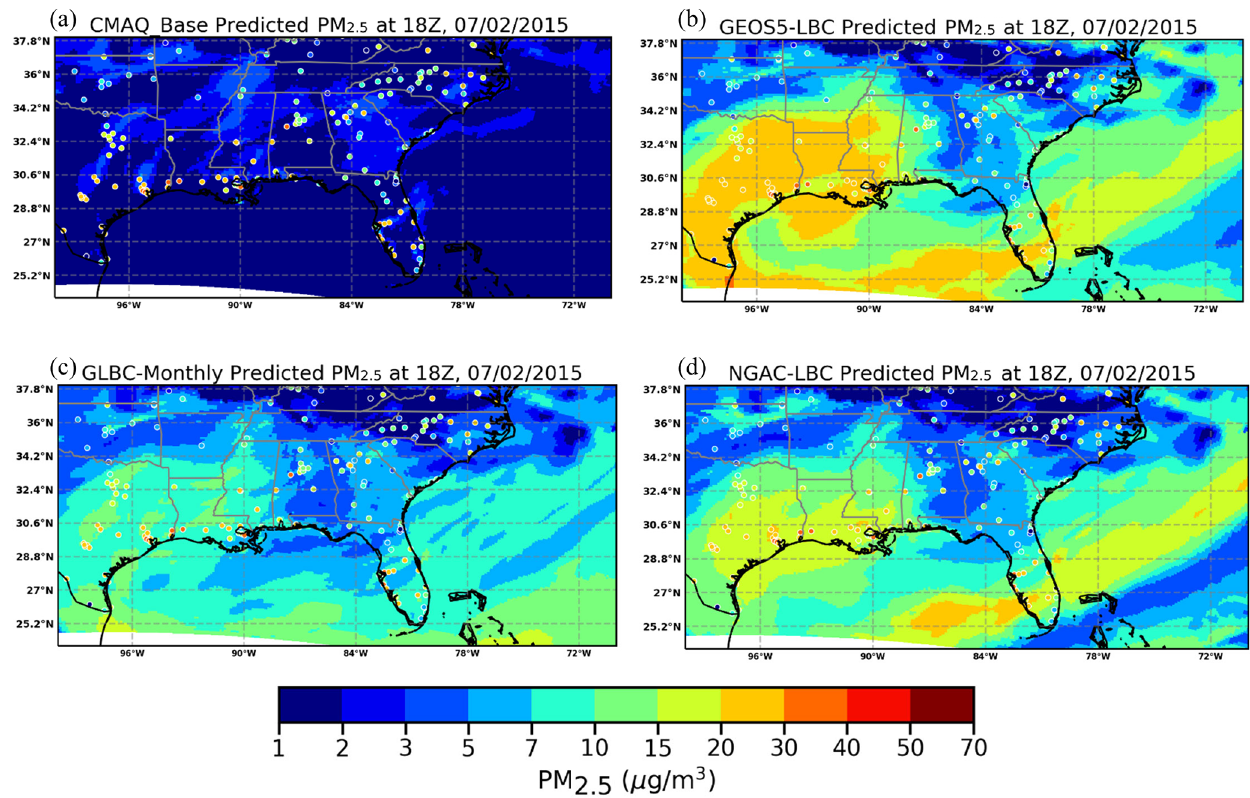
Figure 4. Model-predicted surface PM 2 . 5 concentrations with the four LBCs on 2 July 2015 (the colored circles showing the AIRNow observations). Please note that the dates in this figure are given in the format of month day year